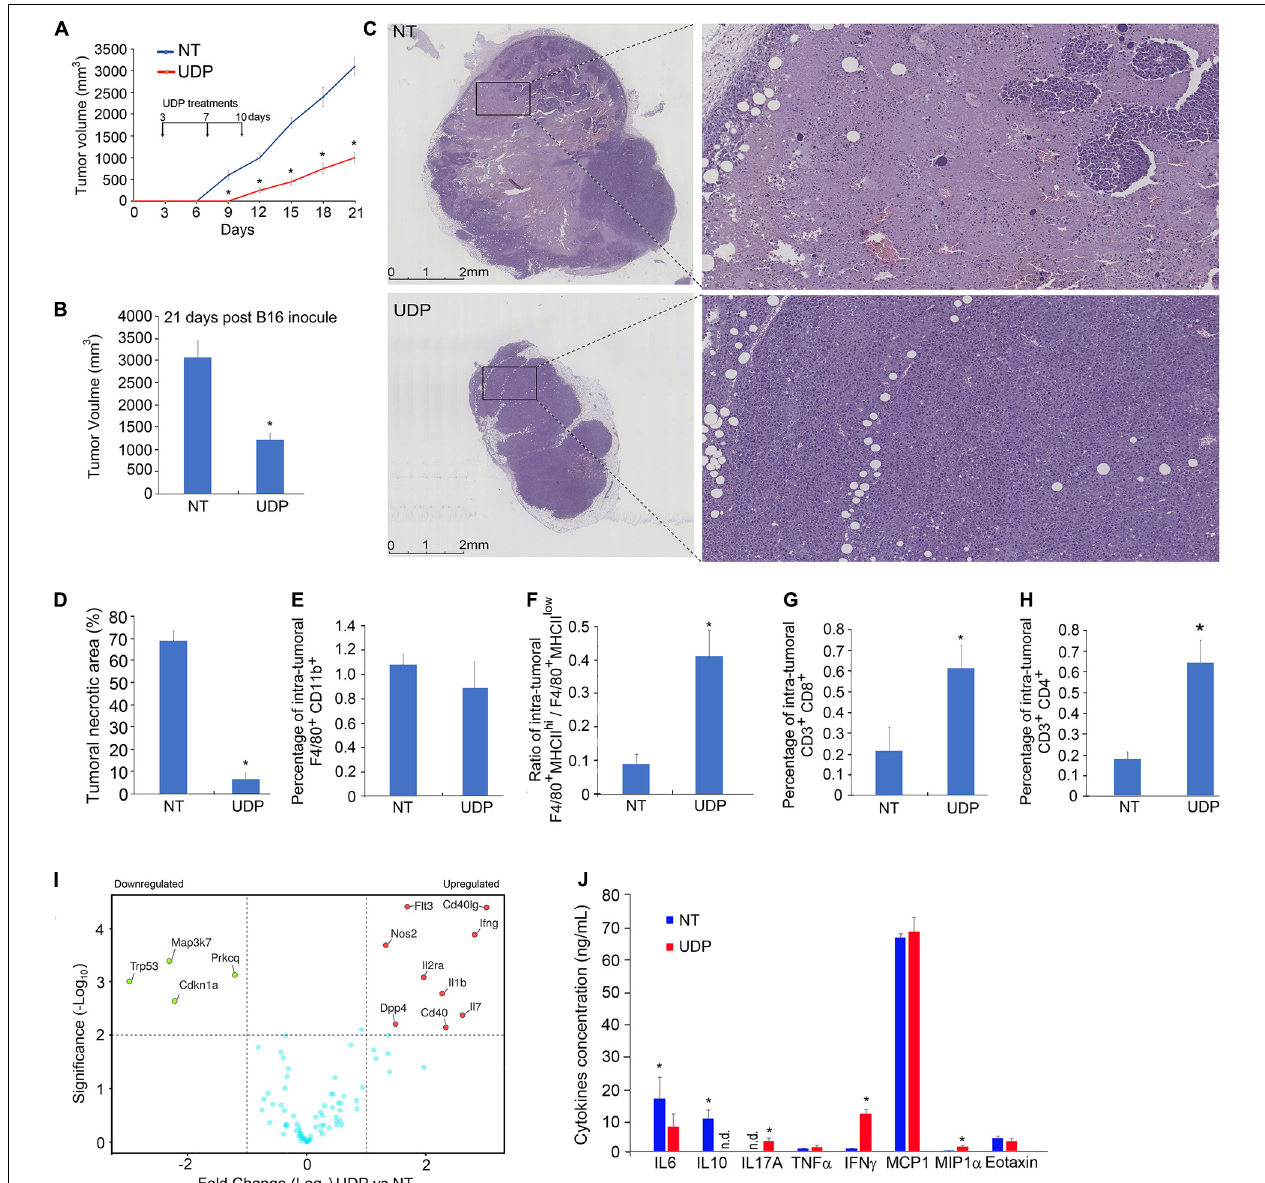
FIGURE 3 | In B16-melanoma-bearing mice, local UDP treatments stimulate anti-tumor response limiting the tumor growth. Two-month-old C57BL6 female mice have been inoculated with 2.0 × 10 5 B16F10 melanoma cell line and treated, in the same localization of engraftment 3, 10, and 17 days later, with 100 µ l of UDP (0.5 mM) or RPMI medium as vehicle. (A) Tumor growth curves and (B) final volume of tumors explanted 21 days post-engraftment. Values (mean ± SE, n = 6 for each group of samples) are shown. The asterisk indicates a statistically significant difference among two groups, according to Student’s t- test ( p < 0.01). (C) Histological analysis of tumors treated with vehicle (upper panels) or UDP (lower panels) by hematoxylin and eosin staining at lower (left panels) or higher magnification (right panels). (D) Necrosis-to-tumor area ratios comparison among mice implanted with B16 tumors treated with vehicle or UDP. Values (mean ± SE, n = 6 for each group of samples) are shown. The asterisk indicates a statistically significant difference among two groups, according to Student’s t -test ( p < 0.01). (E) Percentage of intra-tumoral population of F4/80 + CD11b + detected by fluorescence-activated cell sorting (FACS) using antibodies F4/80-Percp and CD11b-APC. (F) Ratio of F4/80 + /MHCII hi /F4/80 + /MHCII low intra-tumoral populations detected by flow cytometry using F4/80-Percp and MHCII-FITC antibodies. (G) Percentage of intra-tumoral population of TILs CD3 + CD8 + detected by FACS using antibodies CD3-Percp and CD8-FITC. (H) Percentage of intra-tumoral population of TILs CD3 + CD4 + detected by FACS using antibodies CD3-Percp and CD4-PE. Values (mean ± SE, n = 6 for each group of samples) are shown. The asterisk indicates a statistically significant difference among two groups, according to Student’s t -test ( p < 0.01). (I) Total mRNA (1 µ g) extracted from UDP- or vehicle-treated tumors of 8-week-old mice was analyzed for expression of 90 genes involved in B- and T-cell activation (RT 2 Profiler PCR Array B- and T-cell activation mouse, Qiagen). In the volcano plot, genes with a log twofold change ≥ 1 and p < 0.01 ( n = 6 for each group of samples) are considered as differentially expressed. (J) Aliquots of TIF (30 µ l) isolated from UDP- or vehicle-treated tumors of 8-week-old mice were analyzed for the indicated cytokines and chemokines protein expression. Values (mean ± SE, n = 6 for each group of samples) are shown. The asterisk indicates a statistically significant difference according to Student’s t -test ( p <